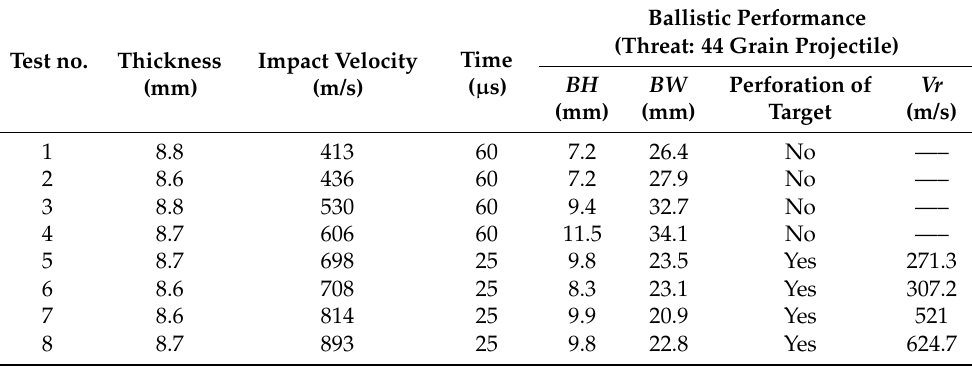
Table 2. Experimental shooting data on the Dyneema HB26 composite